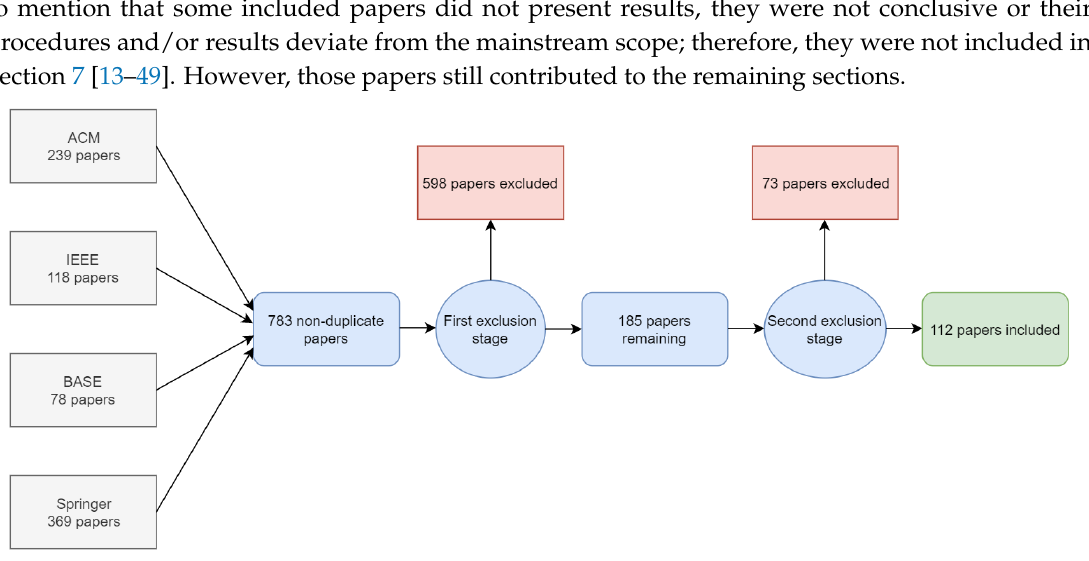
Figure 2. Flowchart of the paper selection for this systematic review.